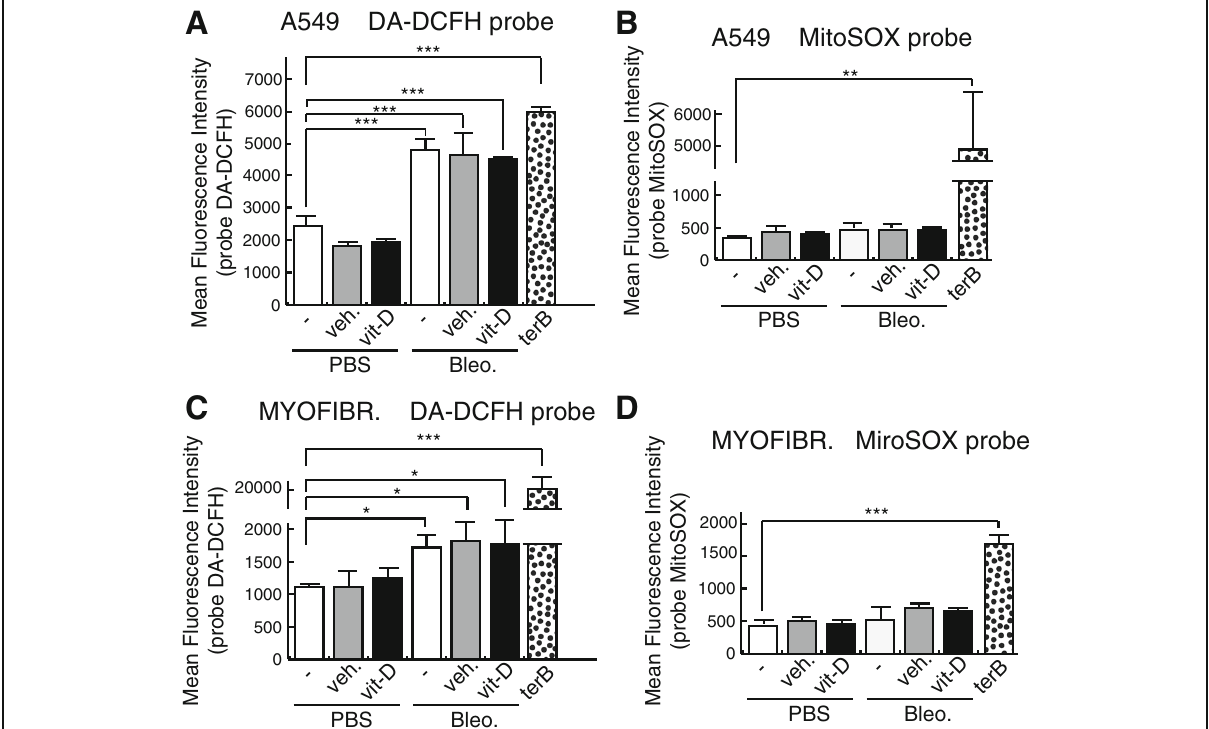
Fig. 5 ROS analyses with DA-DCFH and MitoSOX probes. a Analysis of reactive oxygen species (ROS) by flow citometry of A549 cells (panels a and b ) and myofibroblasts (panels c and d ). Cells were pretreated for 2 h with 5 nmol/L vitamin D and then treated for 24 h with bleomycin (12,5 μ g/mL) and/or 5 nmol/L vitamin D. The cultures were then washed twice with Hank ’ s balanced salt solution (HBSS) and incubated for 1 h with HBSS. After that, the cultures were incubated with DA-DCFH (20 μ M) in HBSS for 1 h, washed and trypsinized. Trypsin was neutralized with HBSS-FBS 2% and the cells were collected and analyzed immediately by flow cytometry. The treatments with MitoSOX were carried-out as for the DA-DCFH probe. Cells were incubated for 1 h with 5 μ M MitoSOX in HBSS and then processed for flow cytometry. Controls for ROS induction employed in these experiments consisted of treatment for 1 h with 50 μ M terbutyl hydroperoxide (terB). The results presented in the graphs are means of the fluorescence intensity ± SEM. ANOVA result a ( P < 0,001), ANOVA results b , c and d ( P < 0,0001). Significance of the analysis post-test is indicated in the figure as *, P < 0.05; **, P < 0.01; and ***, P <